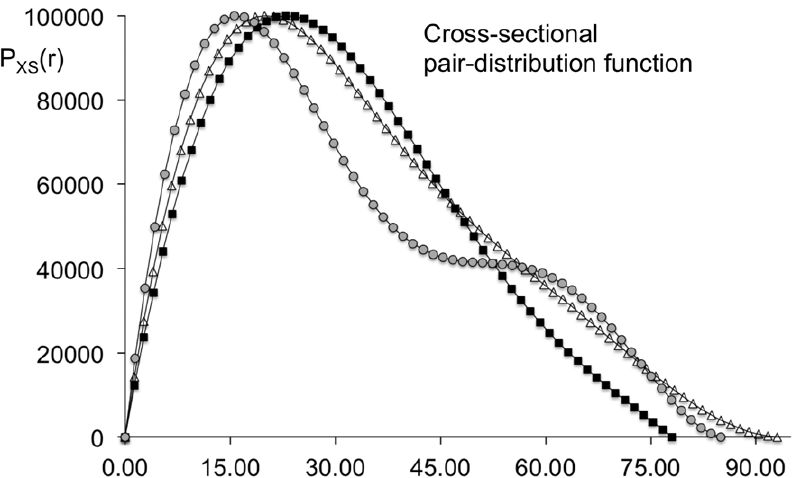
Figure 4. The comparisons of cross-sectional sizes of the tbParB-D120. The cross-sectional pair-distribution functions (P XS (r) versus the pair- wise distance r in A ˚ ) for the 12.0% (open triangle), 85.5% (grey circle) and 73.5% (black square) D 2 O datasets suggests a narrowing of the cross- sectional diameter near the DNA-match point. The P XS (r) functions were scaled to an equal maximal height for visualization purpose. doi:10.1371/journal.pone.0052690.g004 partition assembly between a centromere binding protein, and the centromere region appears to be a common feature in all cases [22]. The crystal structure of a truncated ParR with the centromeric DNA from the plasmid pSK41 showed a large DNA super-helix formation surrounding a protein interior [45].